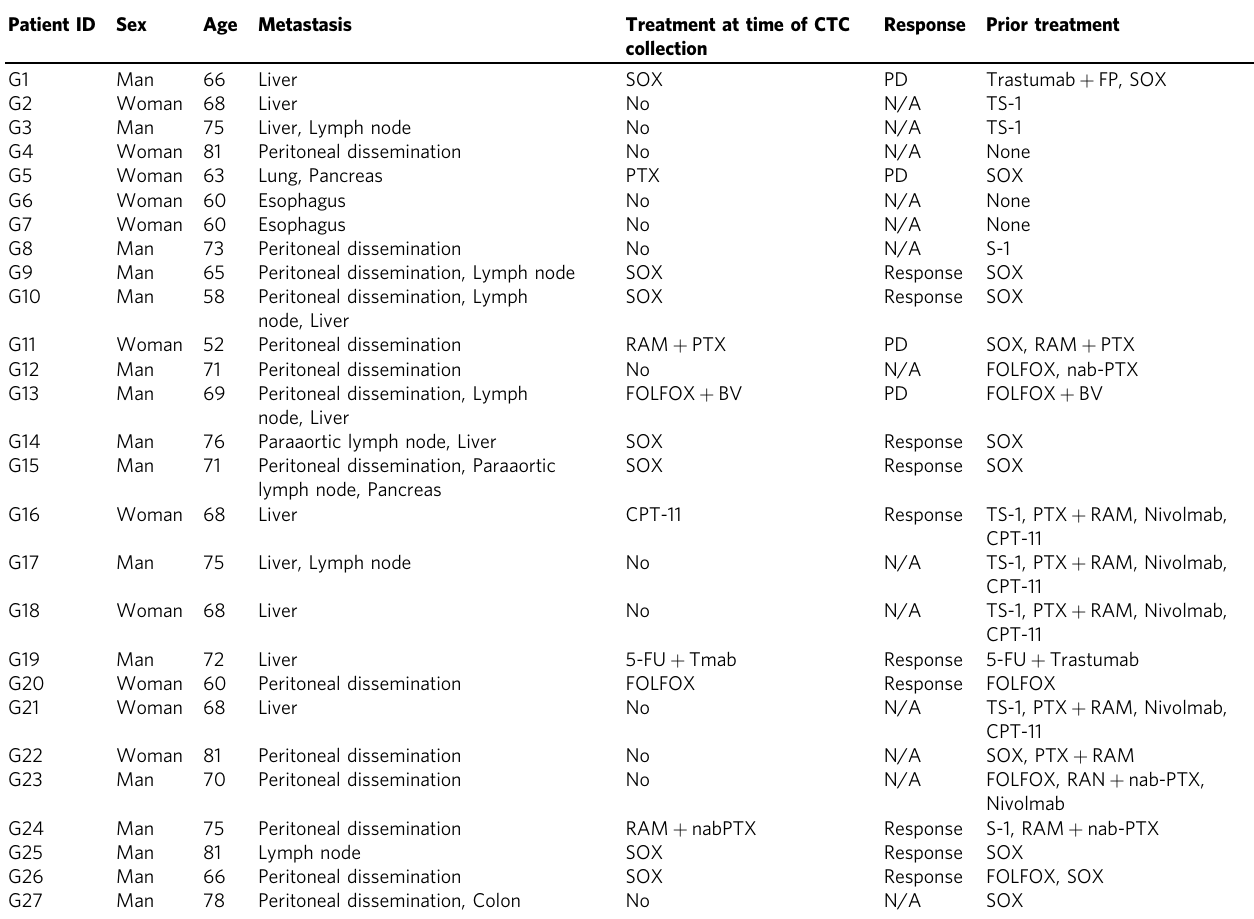
Table 1 Summary of